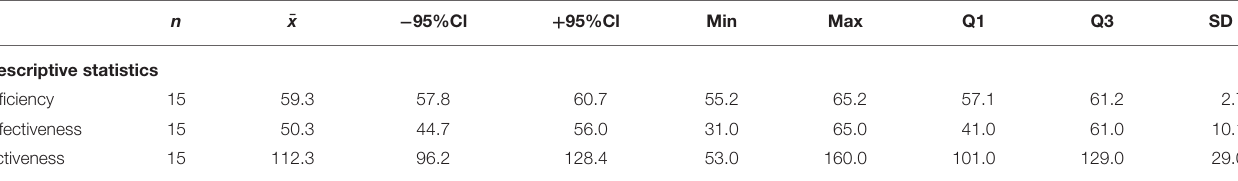
TABLE 4 | Activeness, effectiveness, and efficiency of the